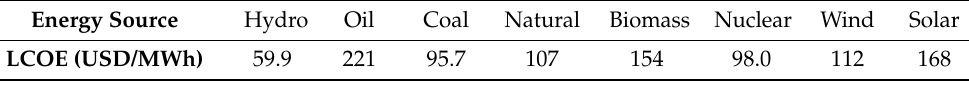
Table 7. LCOE per source for a discount rate of 10%